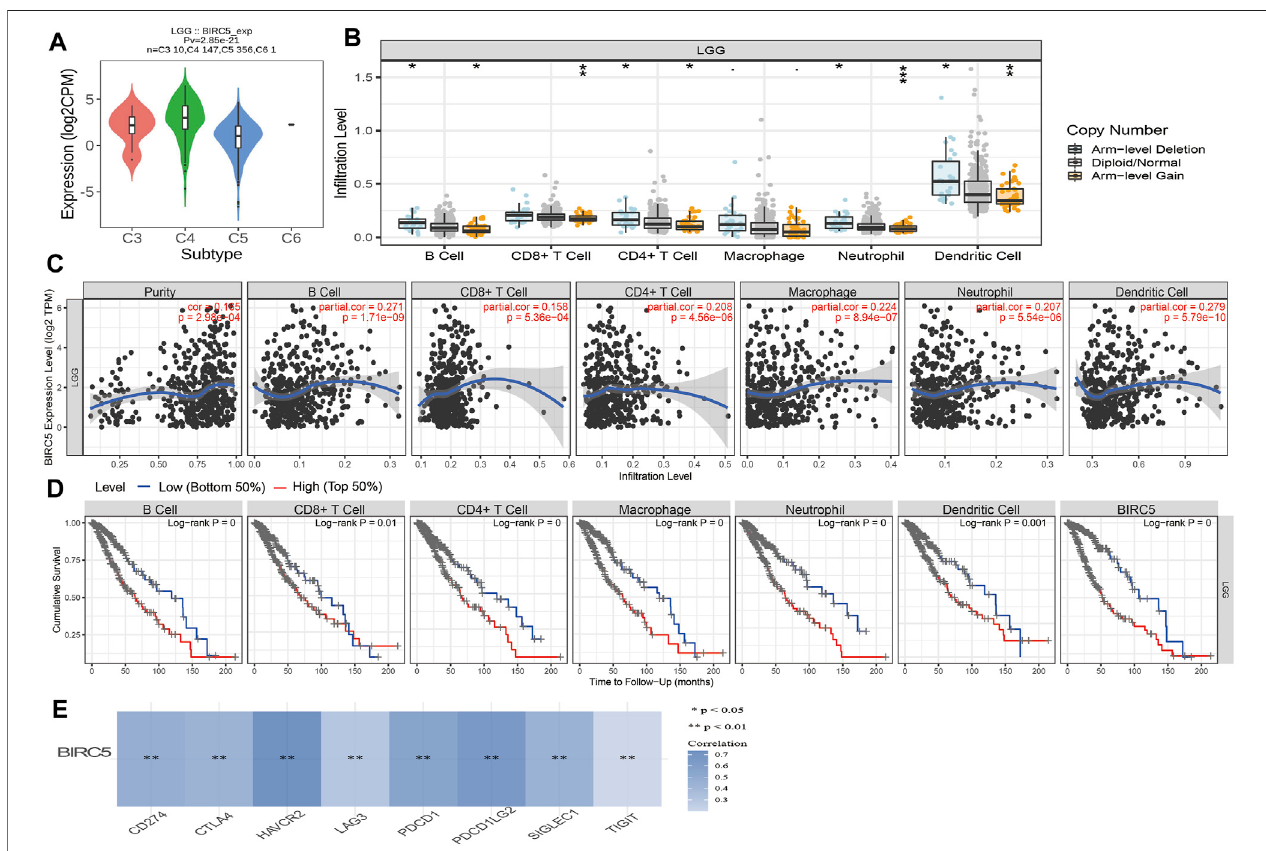
FIGURE 8 | Analysis of the correlation between BIRC5 expression and diverse immune cell in fi ltration. (A) The expression of BIRC5 in diverse immune subtypes of LGG was examined by TISIDB. (B) The correlation between BIRC5 expression and somatic copy number alterations examine by TIMER database. (C) The correlation between BIRC5 expression and diverse immune cell in fi ltration was examined by TIMER database. (D) The B cells, CD4 + T cells, CD8 + T cells, dendritic cells, Macrophages, and Neutrophils are correlated with the cumulative survival rate in LGG examine by TIMER database. (E) The correlations between BIRC5 expression and diverse immune checkpoints related gene examined by TIMER